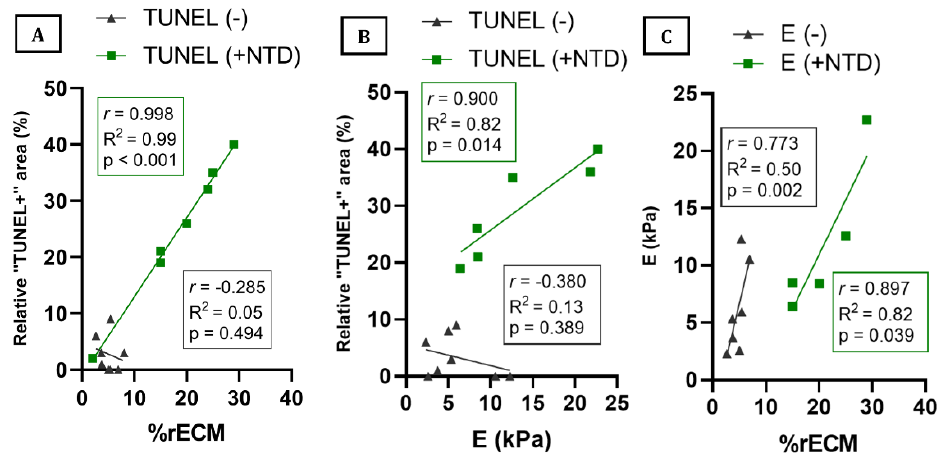
Figure 9. Correlation analysis of ECM-rich area (%rECM), tumor necrosis (TUNEL+), and the stiffness of the ECM-rich areas (E(kPa)) in melanoma macrometastases that received no treatment (triangles, − ) and received nintedanib treatment (squares, +NTD) for 10 days after initial cancer cell injection. ( A ) Correlation analysis between tumor necrosis and ECM production. ( B ) Correlation analysis between tumor necrosis and ECM stiffness of ECM-rich areas. ( C ) Correlation analysis between ECM-rich stiffness and relative tumor area. p -values ( p ) and correlation coefficient ( r ) were obtained by computing the Pearson correlation.